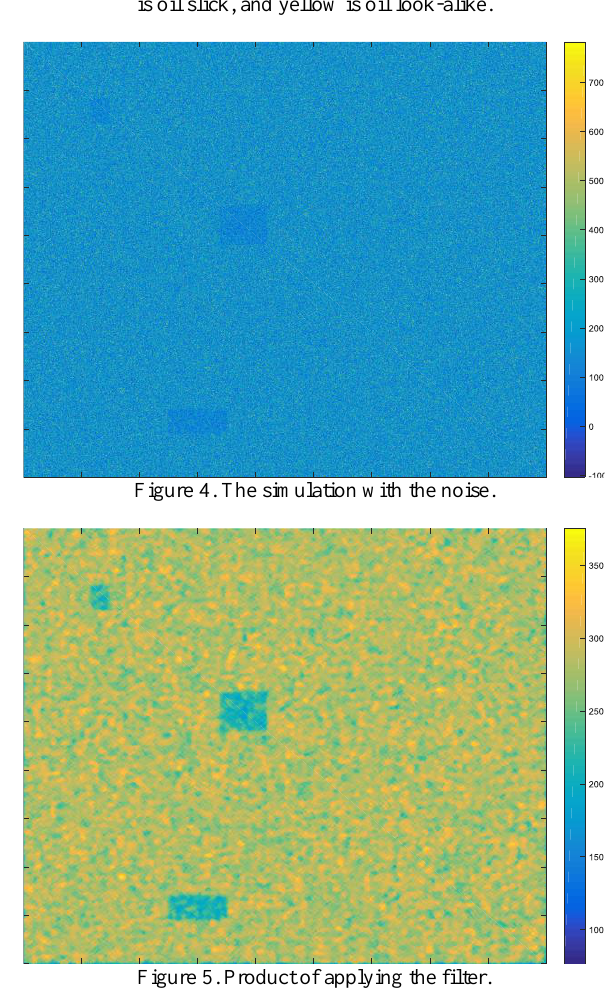
Figure 5. Product of applying the